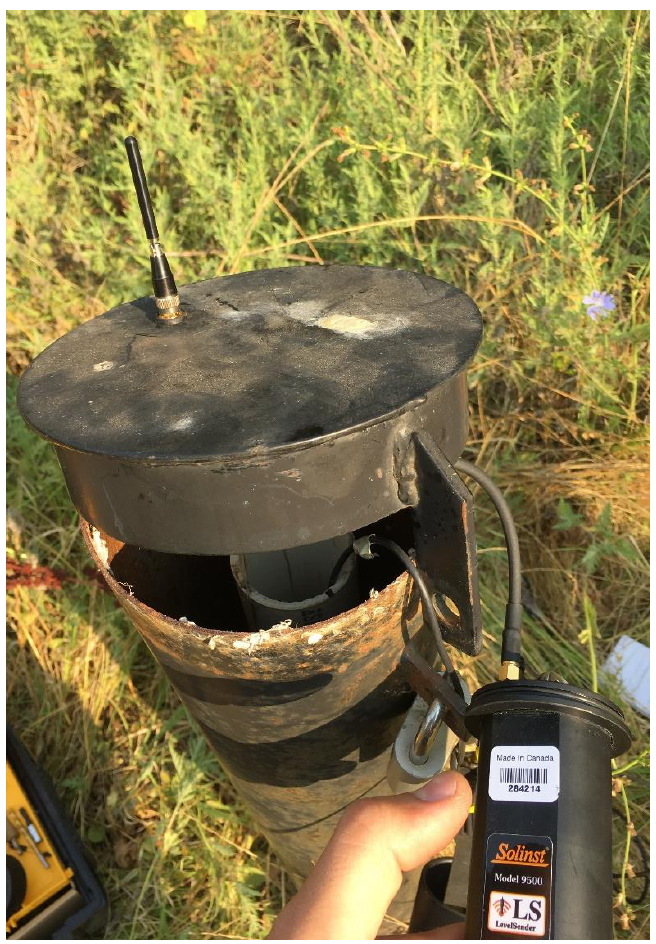
Figure A1. Installation of a telemetry unit with antenna extension in a monitoring well.